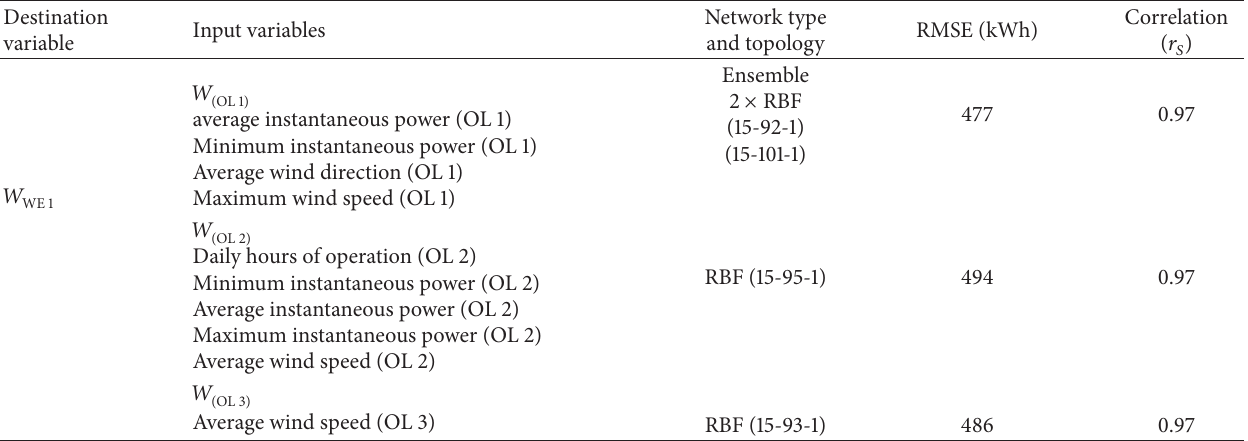
Table 15: Summary of results for the modeled energy output of turbine WE 1 using 13 input variables from the site Olpe